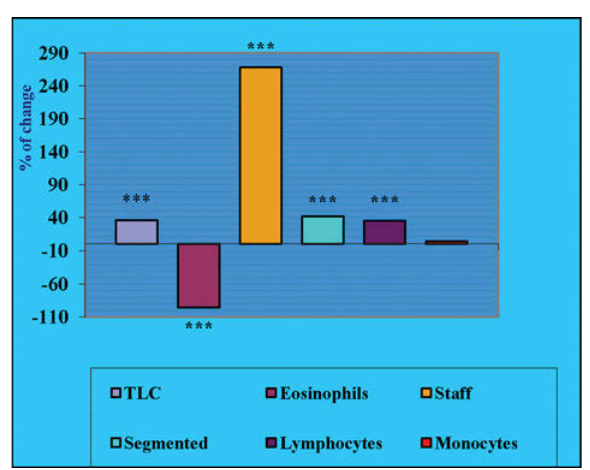
Percentage of change TLC, eosinophils, staff, segmented, lympho- cytes, and monocyte counts after DLIT. DLIT, diode laser inferior turbinoplasty; TLC, total leukocytic count.